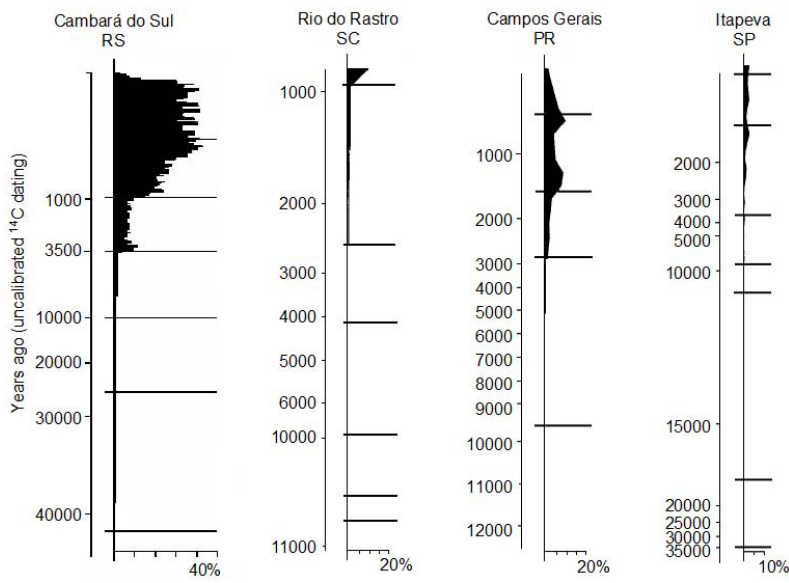
Fig. 3 – Pollen diagrams of A. angustifolia from Cambará do Sul (RS), Serra do Rio do Rastro (SC), Serra dos Campos Gerais (PR) and Morro do Itapeva (SP). Percentages were calculated from the total pollen sum (arboreal and non-arboreal), excluding aquatic taxa. Reproduced from Behling (2002) and Behling et al.